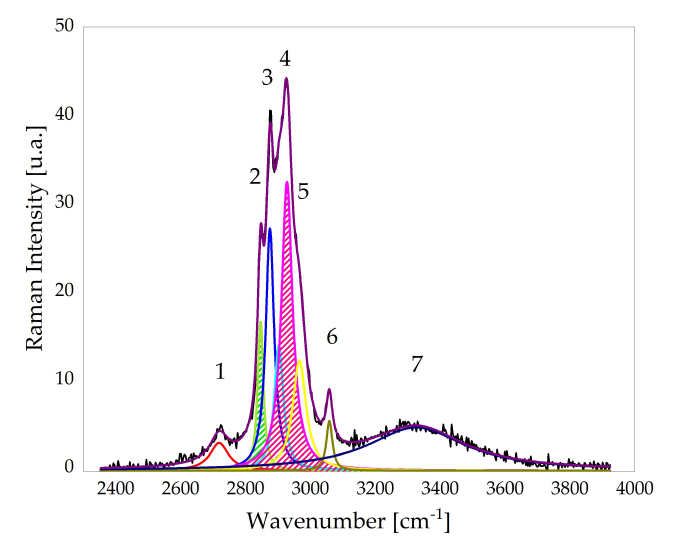
Figure 5. Deconvolution of the typical Raman spectrum of the fern region. The multiple peak fitting was performed in the spectral region 2300–3900 cm − 1 by using seven Lorentzian functions. Green and pink curves correspond to the Raman peaks associated to lipids and proteins, respectively, used to evaluate the ratio R defined in the